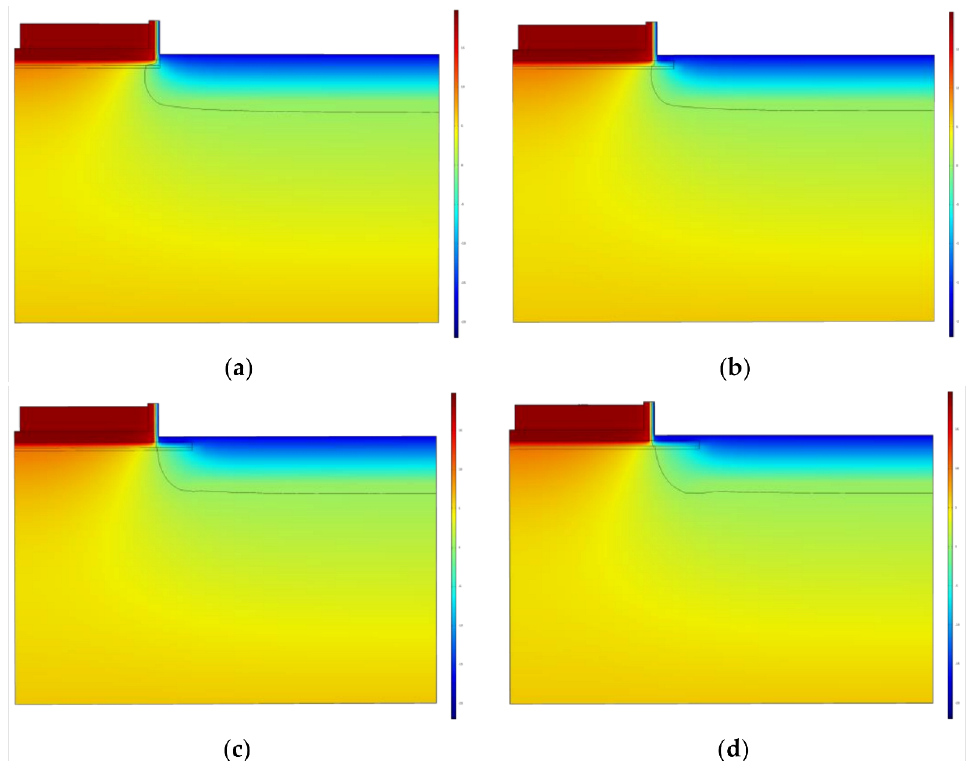
Figure 12. Map of the location of the 0 ◦ C isotherm. ( a ) Model C1 temperature cloud. ( b ) Model C4 temperature cloud. ( c ) Model C7 temperature cloud. ( d ) Model C9 temperature